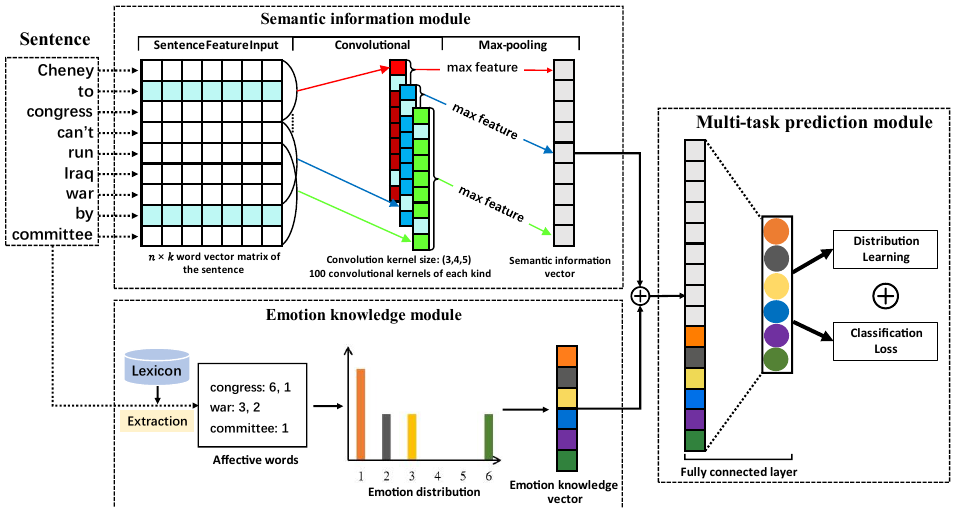
Figure 2. Overall framework of the LMT-CNN model (emotion labels 1: anger, 2: disgust, 3: sadness, 4: surprise, 5: fear, 6: joy).